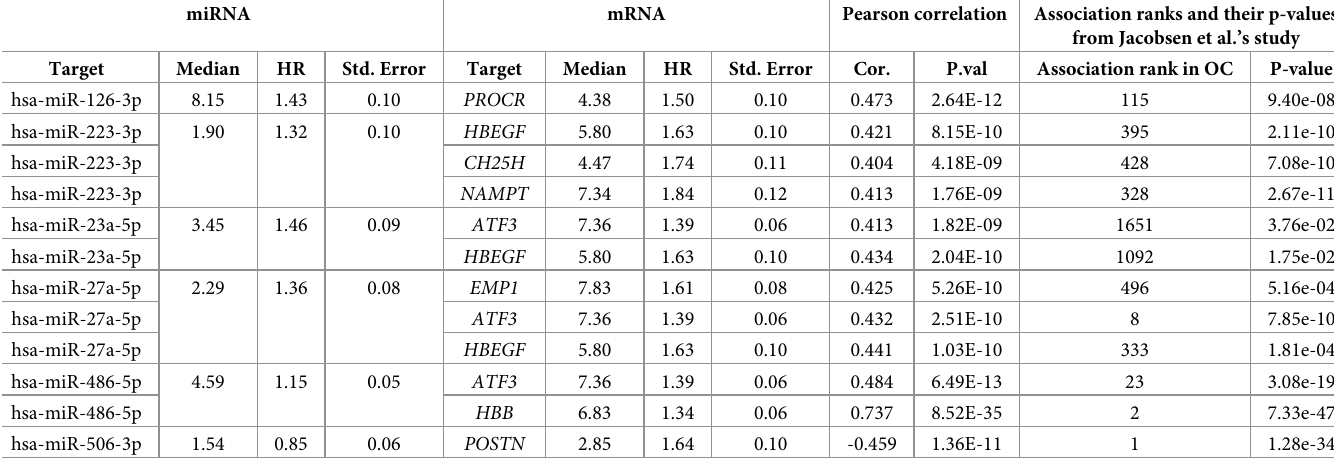
Std. Error: standard error; HR: hazard ratio; Cor.: correlation; P.val: